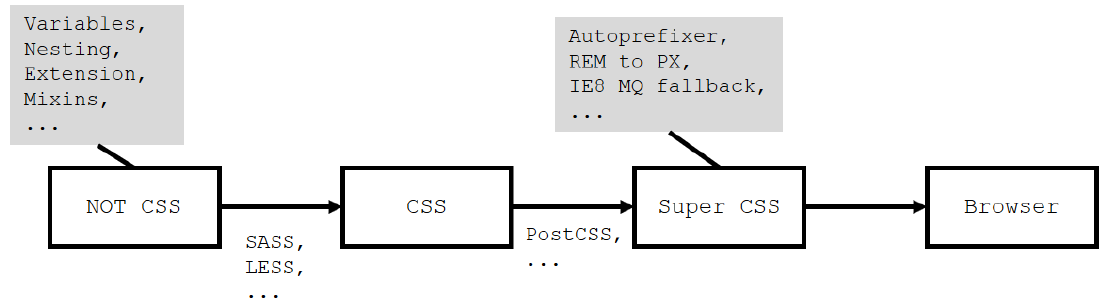
Figure 1. The CSS workflow with the two CSS processor